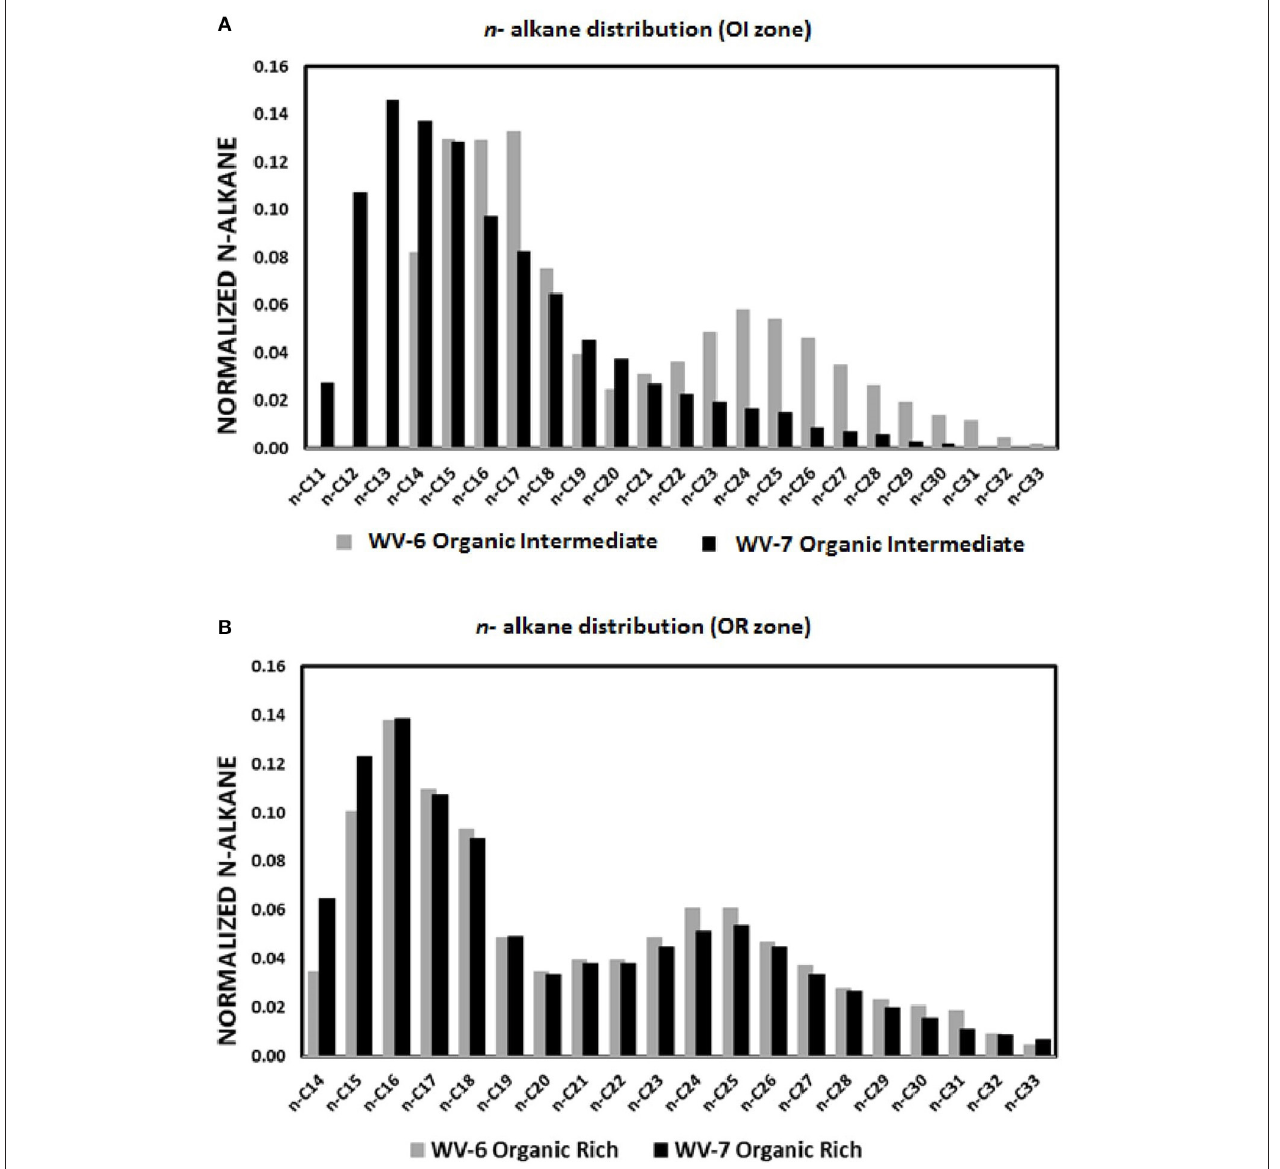
FIGURE 3 | Graphs depicting normalized n-alkane distribution in the shale samples collected from the organic intermediate (OI) (A) and organic rich (OR) (B) zones of wells WV-6 and WV-7. The normalized value of each normalized n alkane biomarker is calculated by dividing concentration of that particular n-alkane with the total concentration of n-alkane